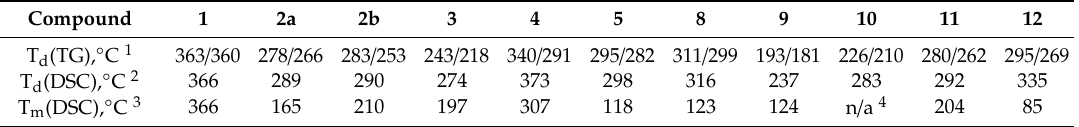
Table 1. Thermal stability of the